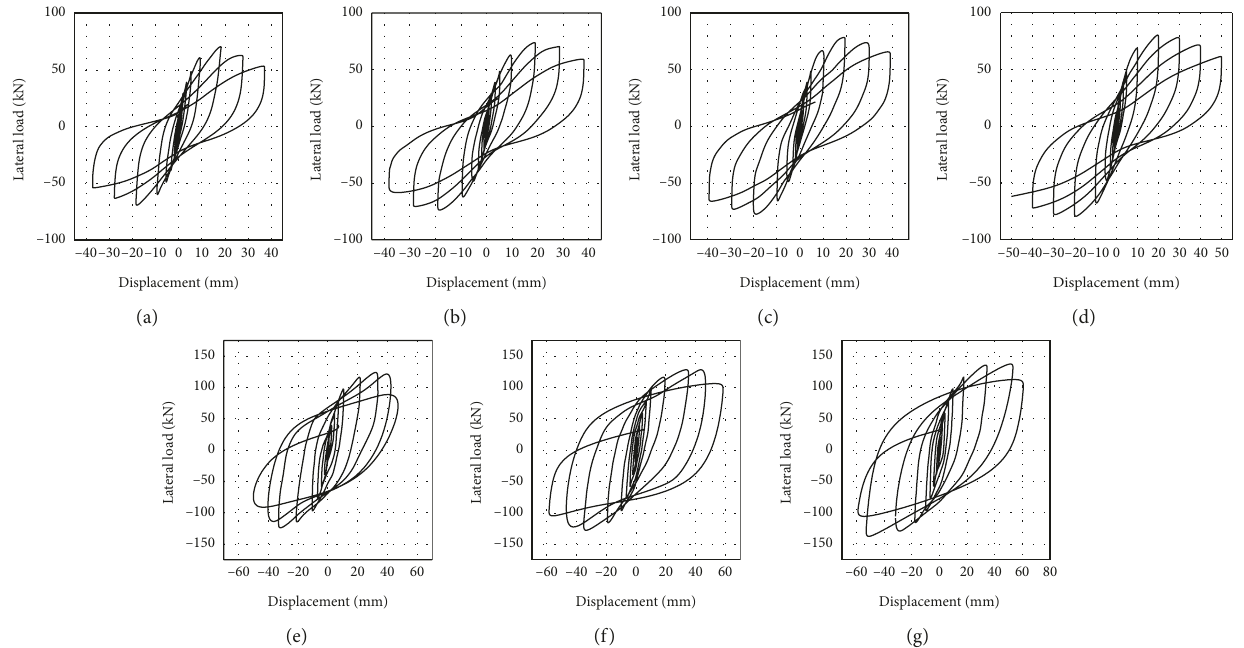
Figure 7: Hysteresis curves of the seven specimens. (a) PC1. (b) SC1. (c) SC2. (d) SC3. (e) TSC1. (f) TSC2. (g) TSC3.